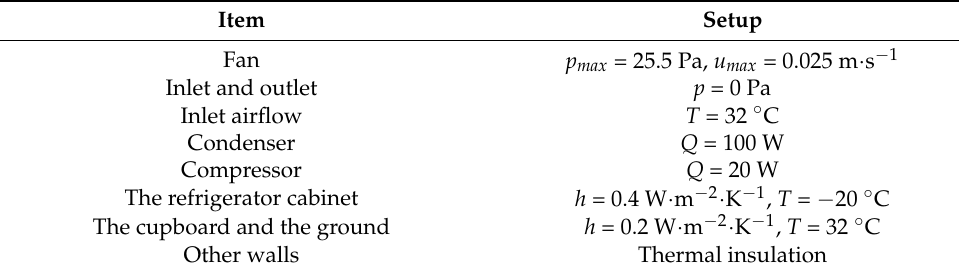
Table 2. Boundary conditions of numerical models.